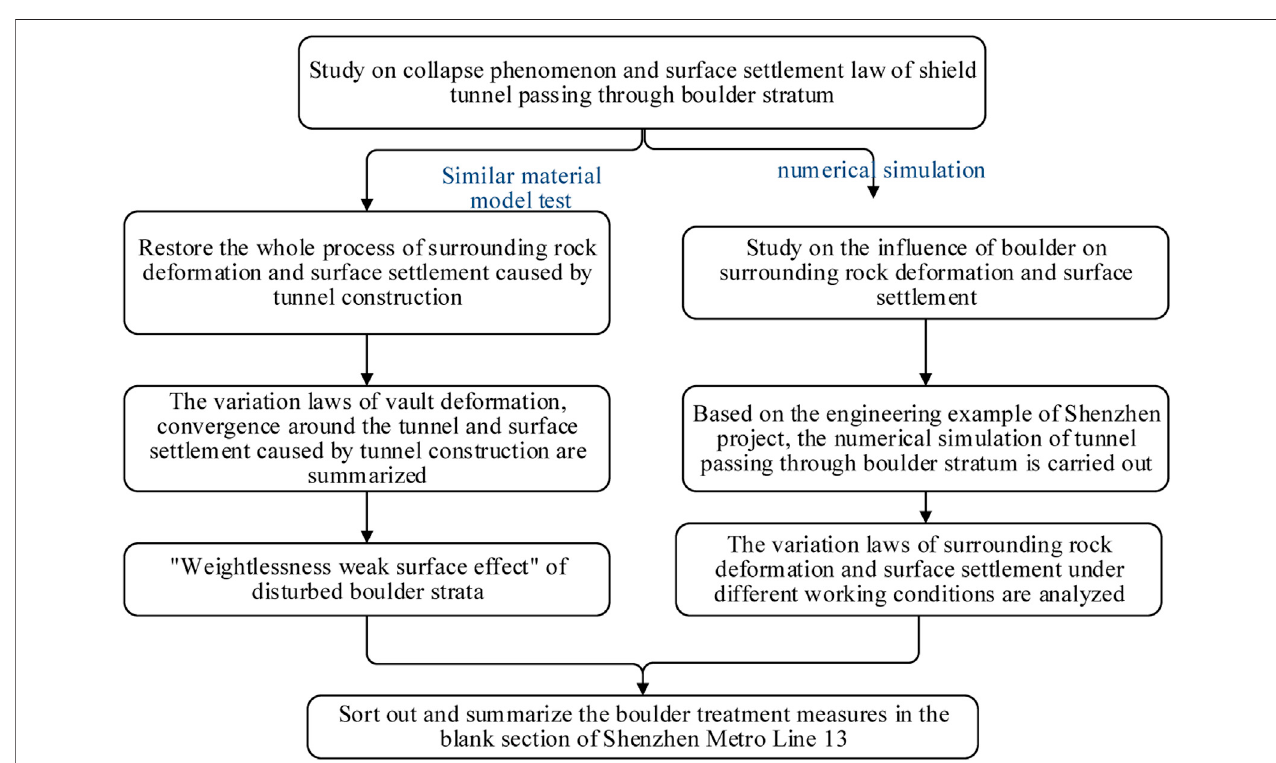
FIGURE 1 | Technology road